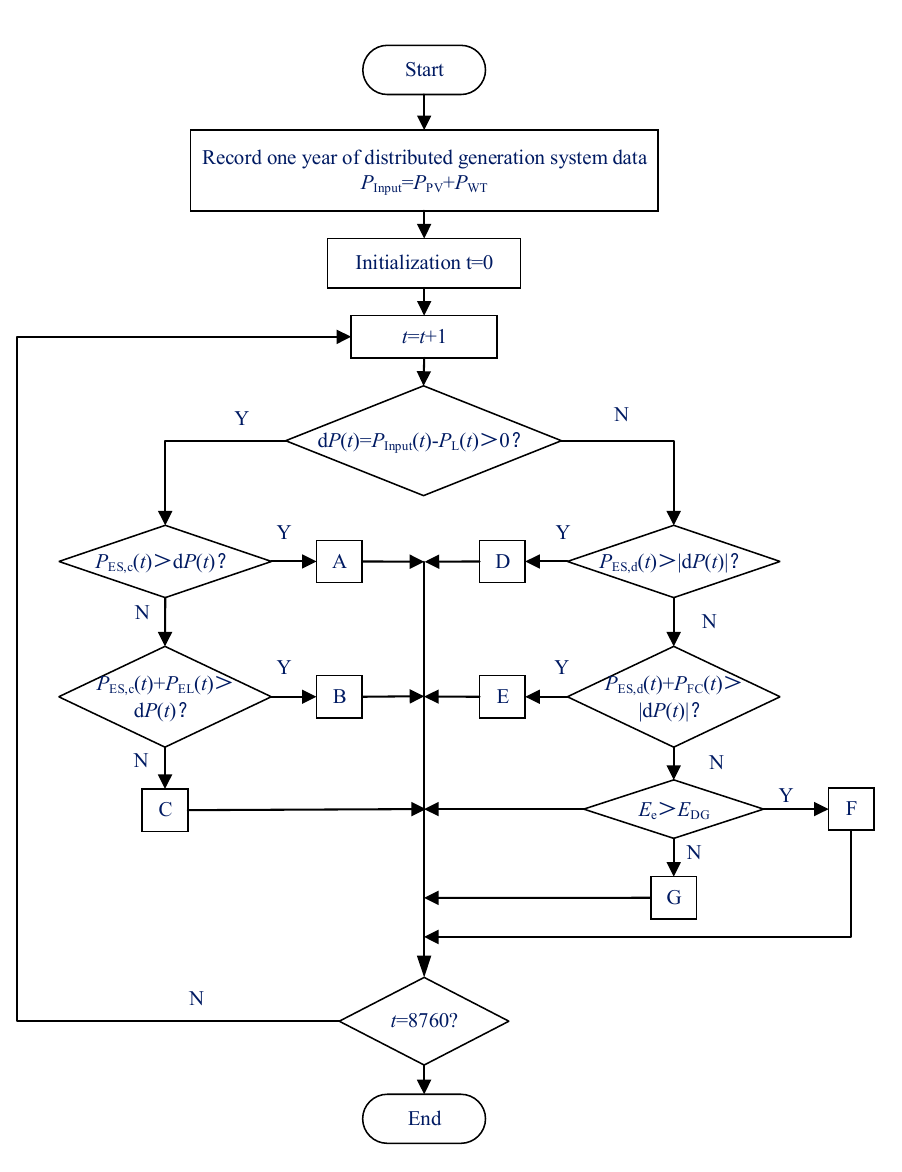
Figure 2. Operation management strategy flow chart.